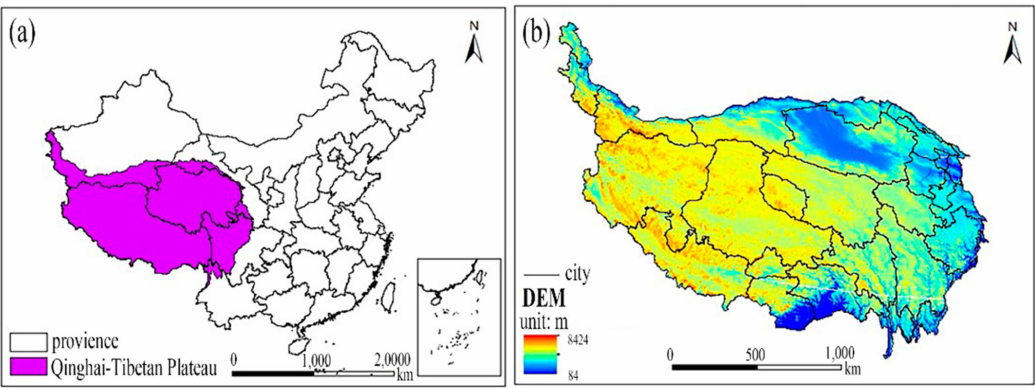
Figure 1. Geographical location ( a ) and elevation ( b ) of the study